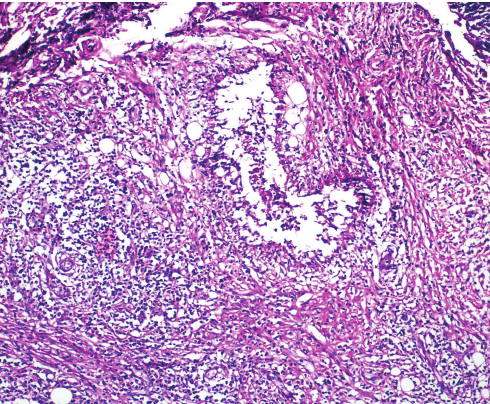
Figure 1: Low power view of the lesion showing granulomatous reaction, mixed inflammatory infiltration, and fibrosis (H & E, 100x).